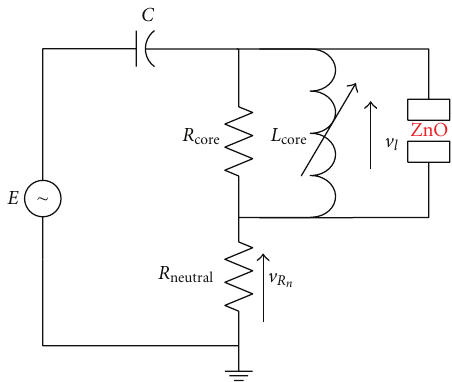
Figure 8: Equivalent circuit of the power system connecting ZnO and earth